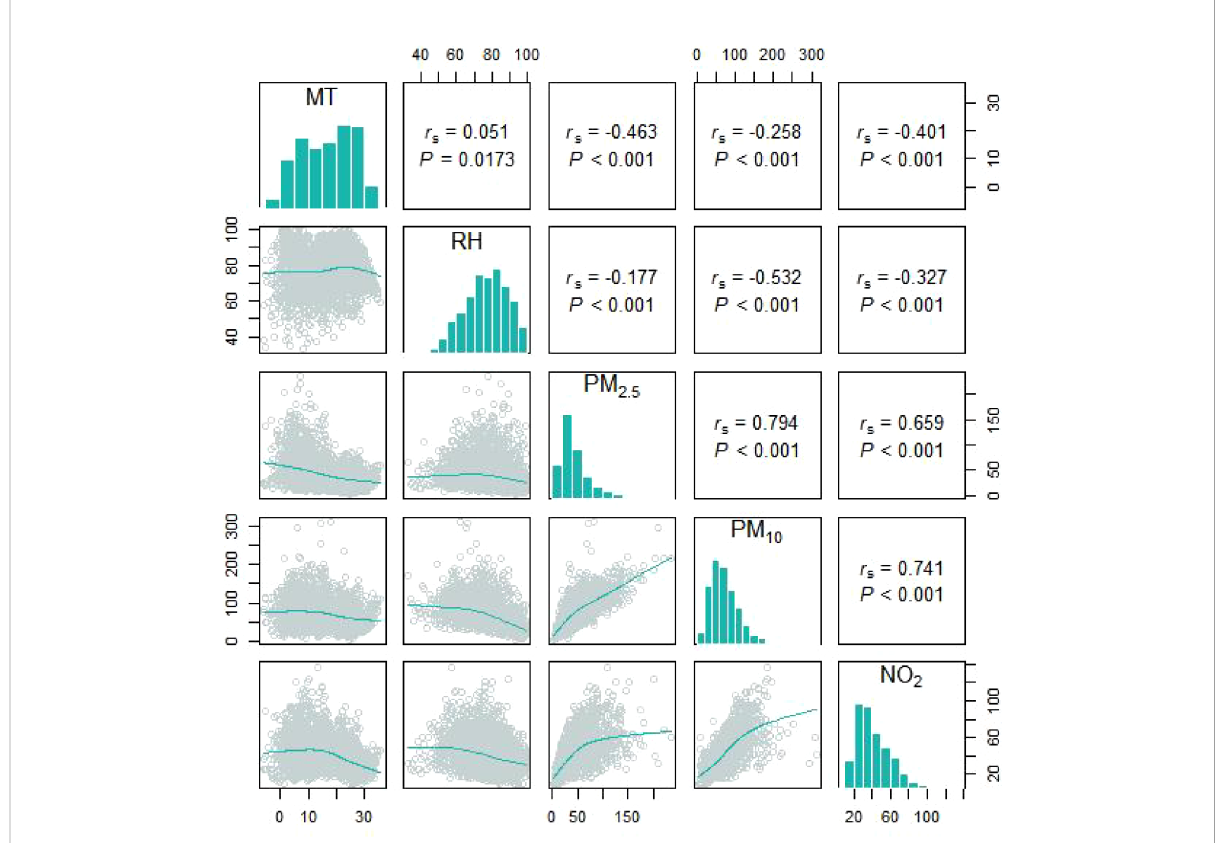
FIGURE 1 The spearman ’ s correlation coef fi cients between different meteorological factors and particulate